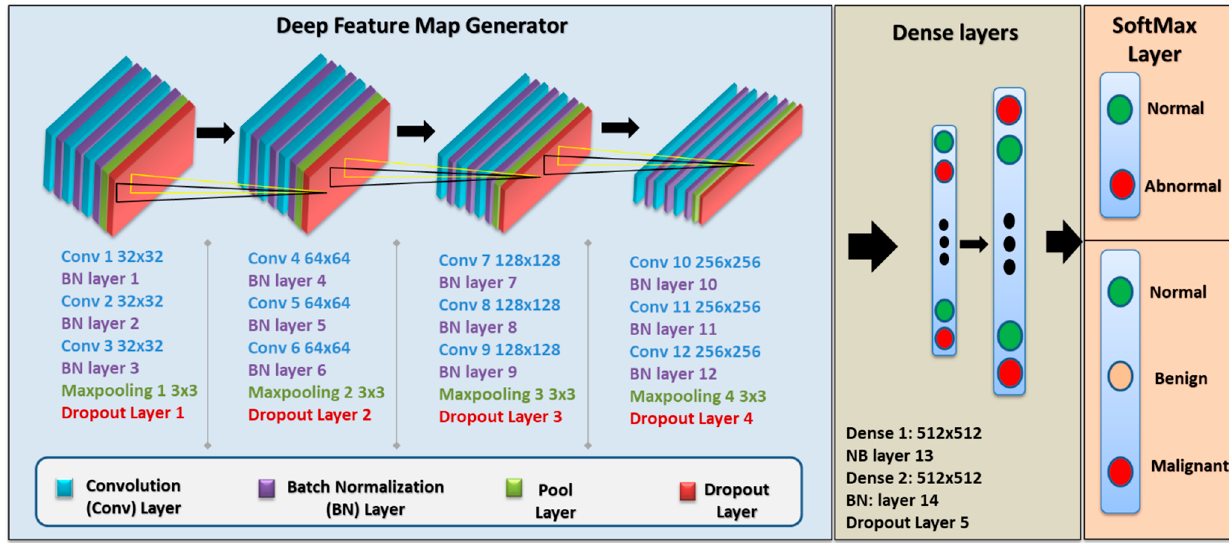
Figure 5. The deep learning structure of our proposed Custom CNN model.